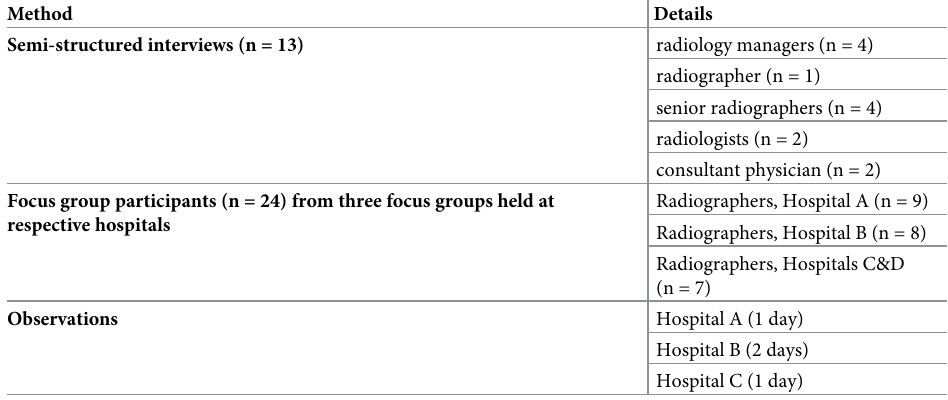
Table 1. Details of data collection methods (and participants where